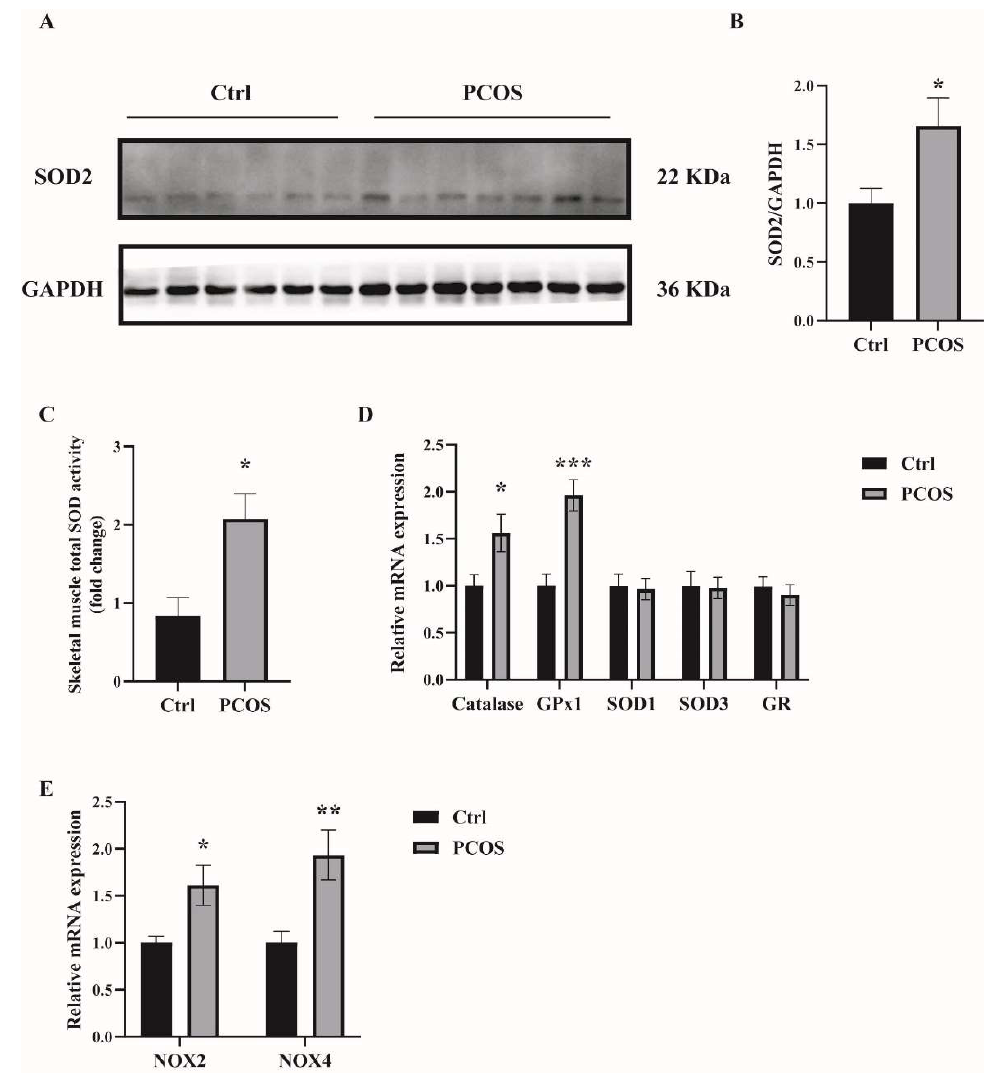
Figure 2. The expression of antioxidant-related genes in the skeletal muscles of the mice. ( A , B ) West- ern blot analysis and densitometry quantification of SOD2 in skeletal muscles of PCOS and control mice. ( C ) Total SOD activity in the skeletal muscles of PCOS and control mice. ( D ) Relative mRNA levels of the genes Catalase , GPx1 , SOD1 , SOD3 , and GR in the skeletal muscles of PCOS and control mice. ( E ) Relative mRNA levels of the genes NOX2 and NOX4 in the skeletal muscles of PCOS and control mice. Asterisks indicate significant differences between control and PCOS mice. The data are presented as means ± SEM. *, p < 0.05, **, p < 0.01, ***, p < 0.001, n = 6,7 per group.